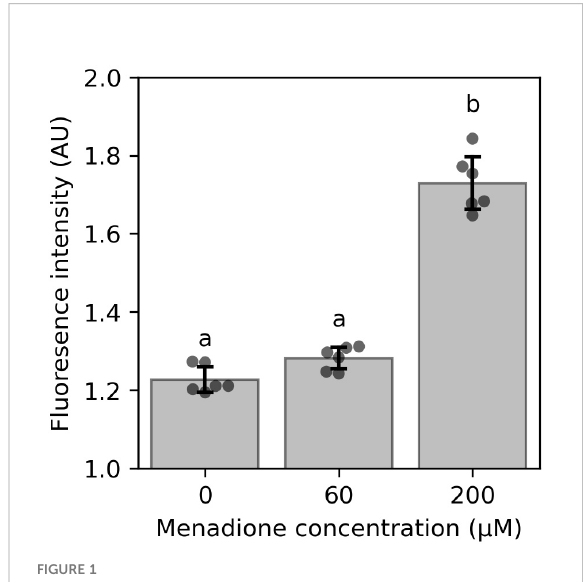
FIGURE 1 Effect of menadione on ROS production in 4-d-old heterotrophic arabidopsis cell cultures quanti fi ed by H 2 -DCFDA fl uorescence. Cells were incubated with menadione for 6 h prior to measurement. Values are the mean ± SD, n = 6. Different letters represent values that differ signi fi cantly as determined by one-way ANOVA followed by Tukey test (P< 0.05). AU – arbitrary